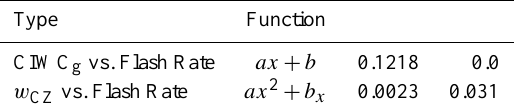
Table 2. Regression curves of minimum thresholds for graupel columnar ice water content (CIWC g , in kgm − 2 ) and vertical wind at the bottom of the CZ ( w CZ , in ms − 1 ) with respect to total (IC + CG) flash rate, and relative coefficients derived from the data displayed in Fig. 16 (the red lines in the two